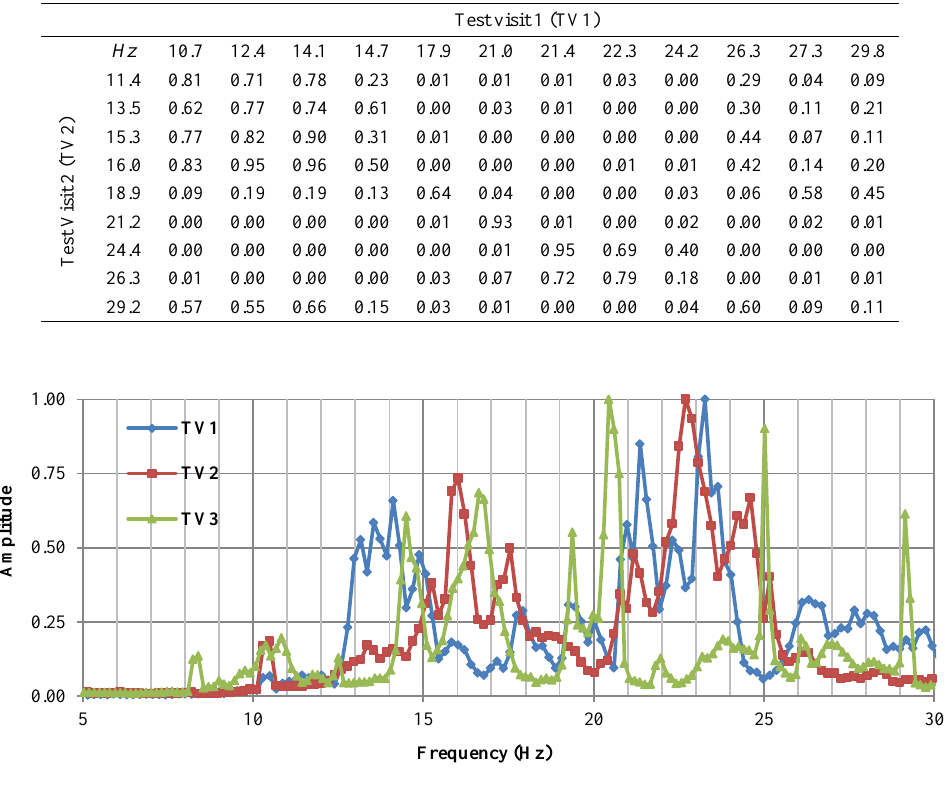
Fig. 8. First singular value plots of the vertical response of the first floor during TV1, TV2 and